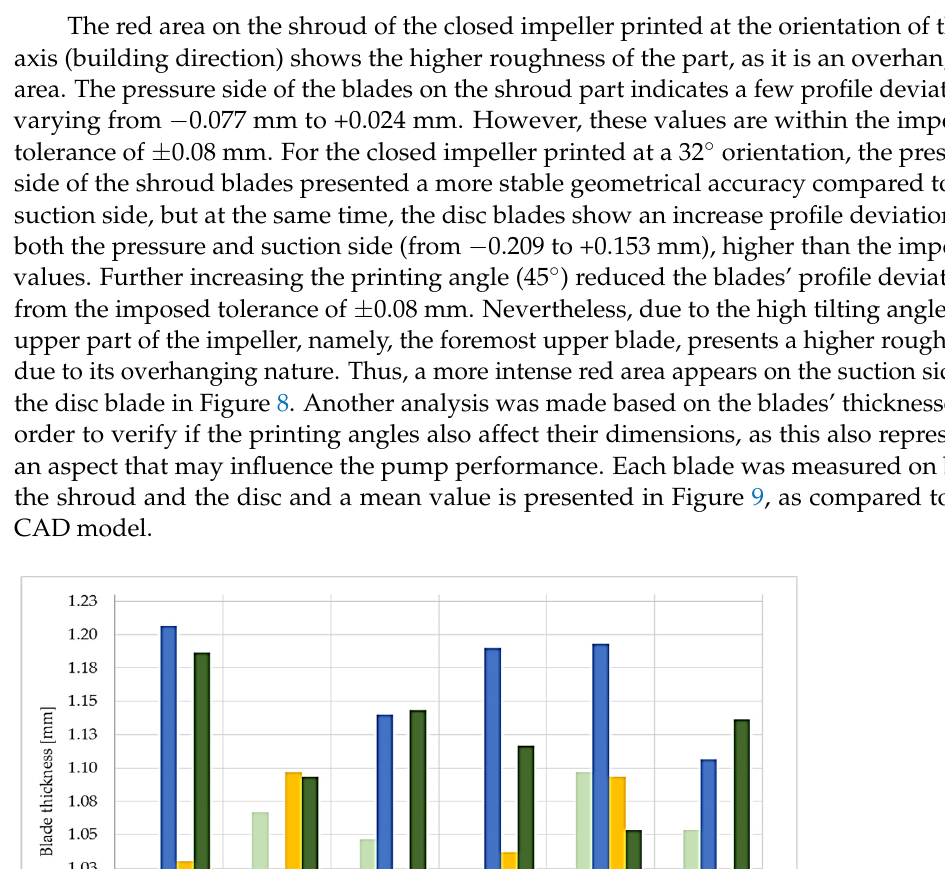
Figure 8. Geometrical evaluation of the AM closed impellers: ( a ) evaluation of the closed impeller for 0°; ( b ) evaluation of the closed impeller for 32°; ( c ) evaluation of the closed impeller for 45°.